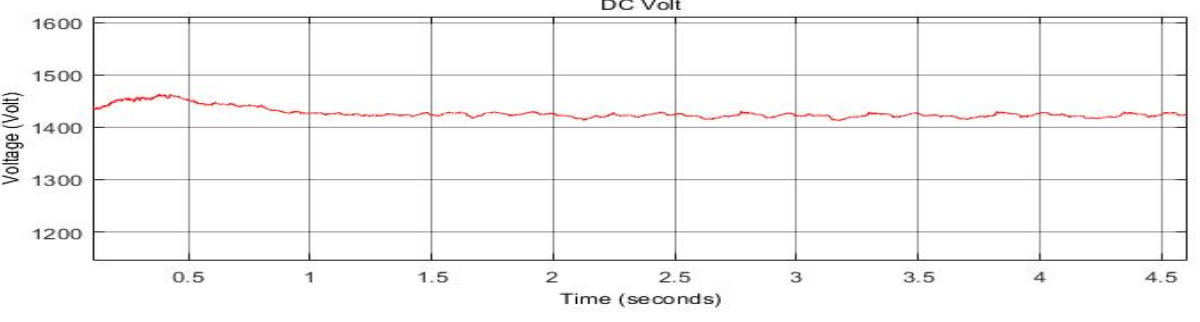
Figure 23. DC source voltage.